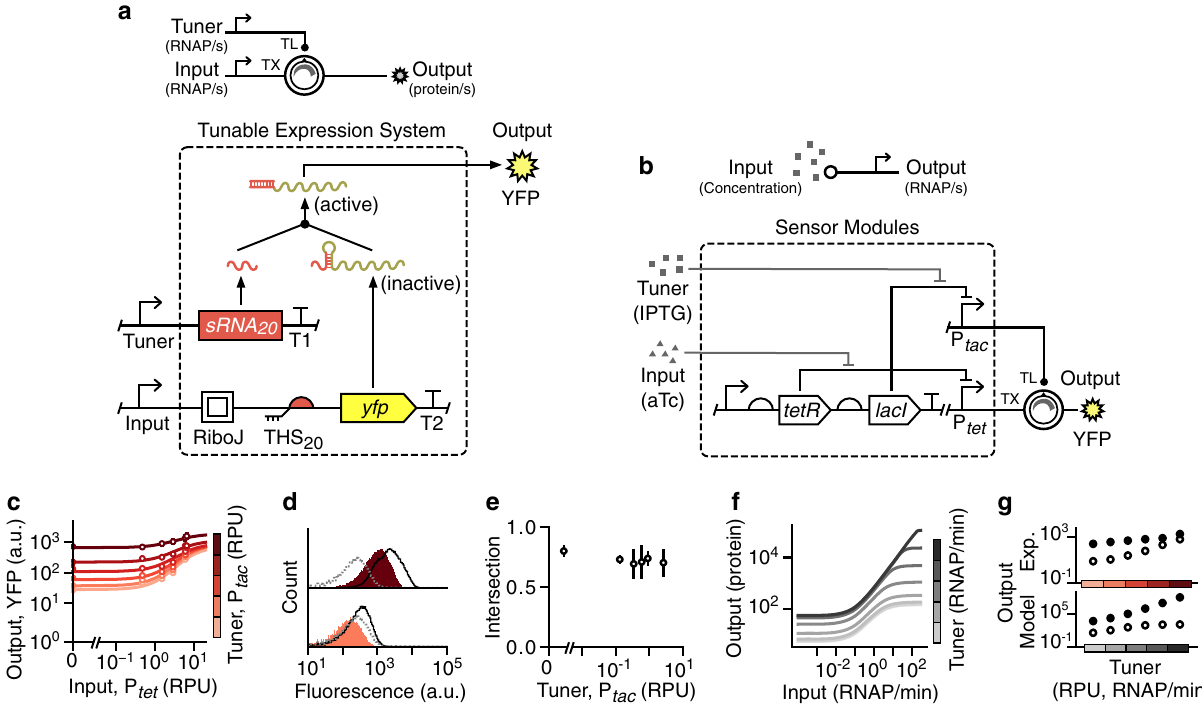
Fig. 1 Design and characterization of a tunable expression system (TES). a Schematic of the TES (top) and genetic implementation using a THS (variant 20) 28 to regulate translation initiation rate of an output protein (bottom, dashed box). Yellow fl uorescent protein (YFP) is used as the output and T1 and T2 correspond to the transcriptional terminators L3S3P11 and L3S2P21, respectively 65 . b Genetic design of the sensor modules used to drive the main and tuner inputs to the TES. c Experimentally measured response functions for the TES. Points denote the average of three biological replicates and error bars show ±1 standard deviation. Each line shows a fi tted Hill function for a fi xed tuner input (color scale light – dark: 0.002, 0.03, 0.15, 0.43, 0.9, 2.6 RPU). d Flow cytometry distributions of output YFP fl uorescence when the tuner promoter activity is low (bottom; 0.002 RPU) and high (top; 2.6 RPU). Black outlined distributions correspond to a high input promoter activity (6.6 RPU) and the fi lled red distributions to a low input promoter activity (0.002 RPU). Cell auto fl uorescence is shown by the dashed gray line. e Fraction of intersection between YFP fl uorescence distributions for low (0.002 RPU) and high (6.6 RPU) inputs across varying tuner promoter activities. Points denote the average of three biological replicates and error bars show ±1 standard deviation. f Response functions from a deterministic model of the TES (Supplementary Note 1). Output shown as the steady-state protein level. Line color corresponds to the promoter activity of the tuner input (light – dark: 0.0001, 0.06, 0.3, 1.5, 7.6, 38, 190 RNAP/min). g Comparison of the output for high ( fi lled circles; 6.6 RPU) and low (un fi lled circles; 0.002 RPU) inputs across a range of tuner promoter activities (Experiment: 0.002, 0.03, 0.15, 0.43, 0.9, 2.6 RPU; Model: 0.0001, 0.3, 1.5, 7.6, 38, 190 RNAP/min). Source data are available in the Source Data fi